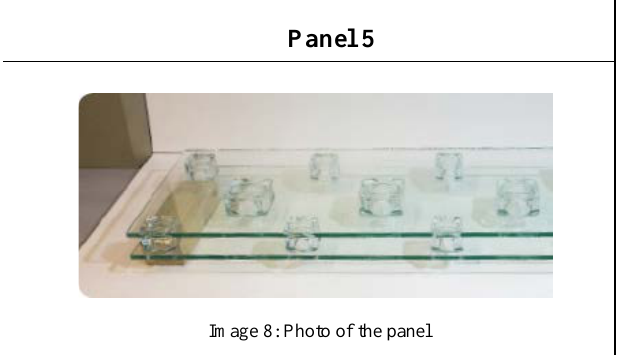
Image 8: Photo of the panel